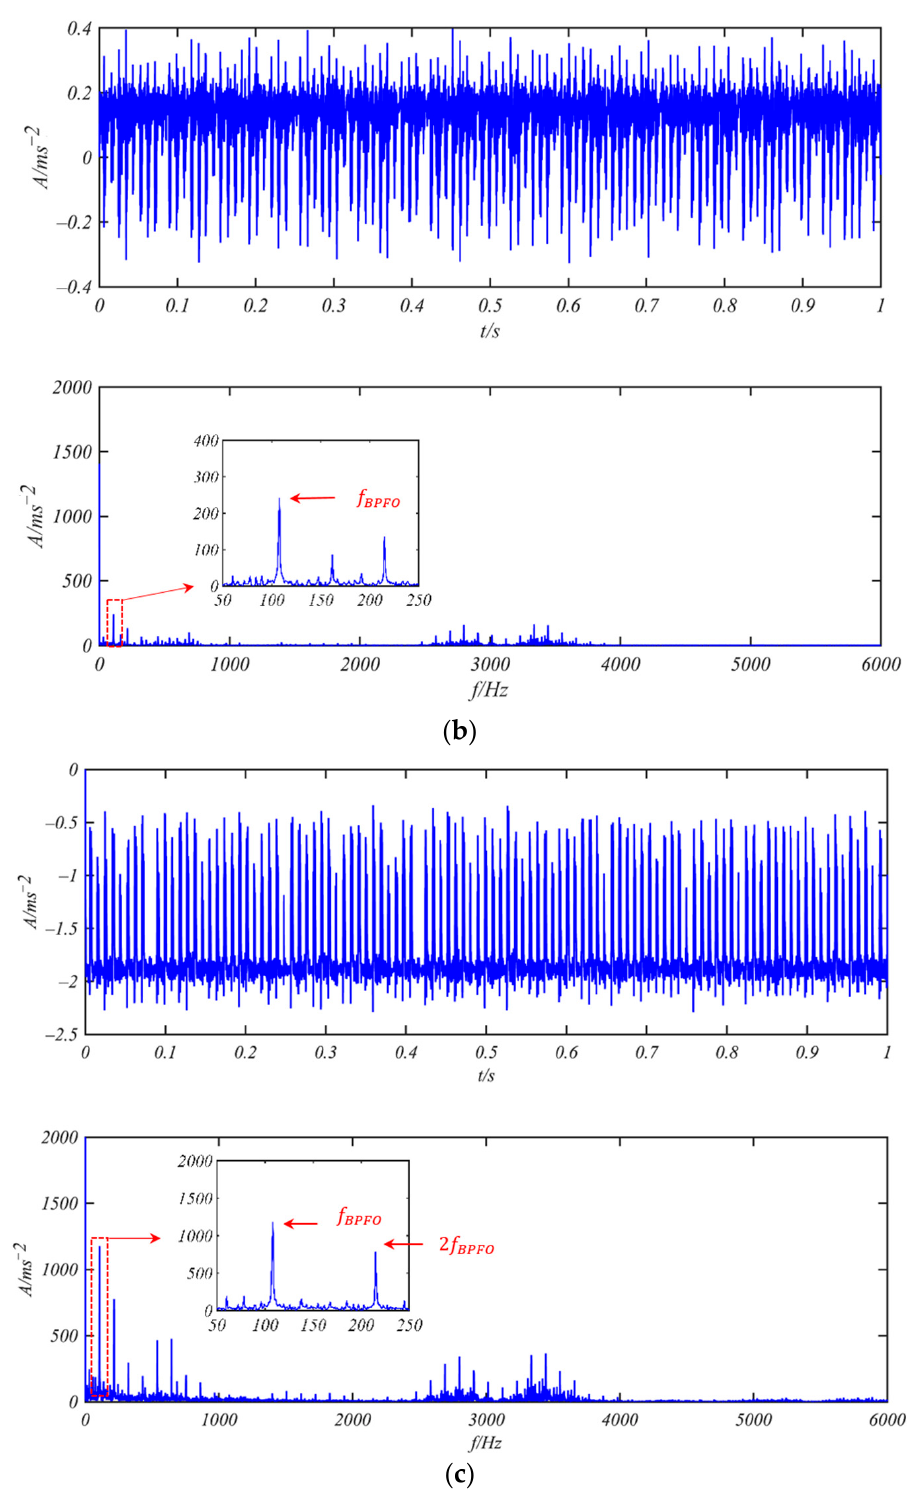
Figure 9. Comparison between different models to process bearing 6205 with outer ring fault: ( a ) origin time-domain waveform and spectrum; ( b ) time-domain signal and its spectrum processed by CBSR model; and ( c ) time-domain signal and its spectrum processed by PNABSR model.